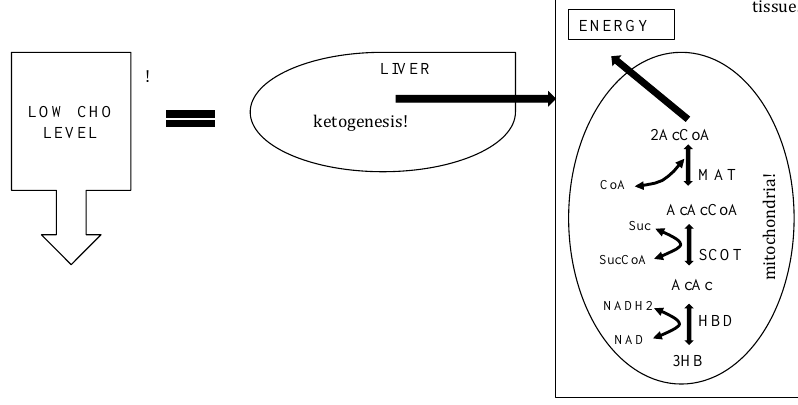
Figure 3. Metabolic pathway of ketosis and tissues ketolysis.